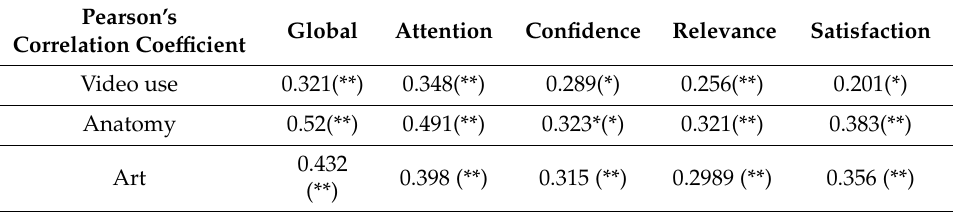
Table 5. Correlations between the performance and motivation shown by students and the levels of confidence (C), attention (A), satisfaction (S) and relevance (R), by identified t-values (note: significant at * = 0.05 and ** =